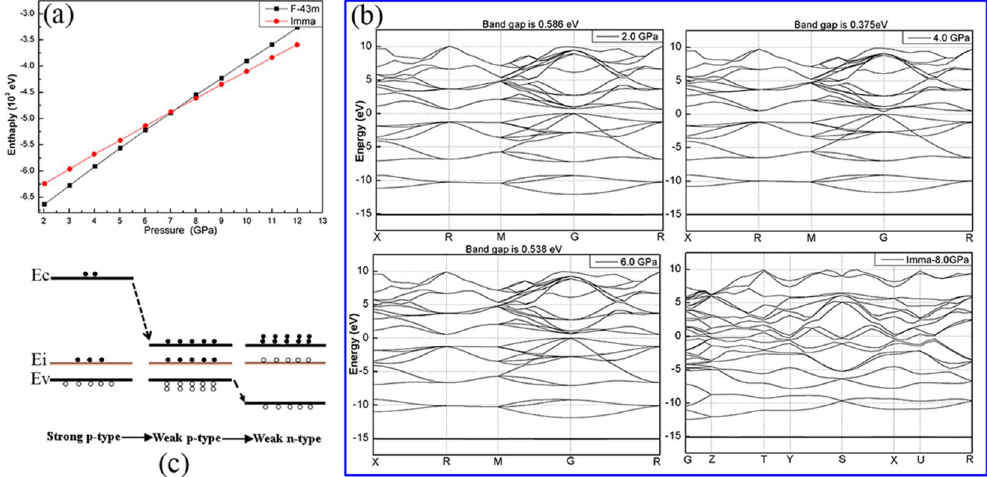
Figure 5. ( a ) The change enthalpy vs. pressure relationships of the F-43m and Imma phases of GaSb; ( b ) Calculated band structure under different pressure; ( c ) A sketch for the changing of band structure in F-43m phase; Ec, Ev, and Ei represent the conduction-band minimum, valence-band maximum, and impurity level; the soild and open circles repersent the electrons and holes,